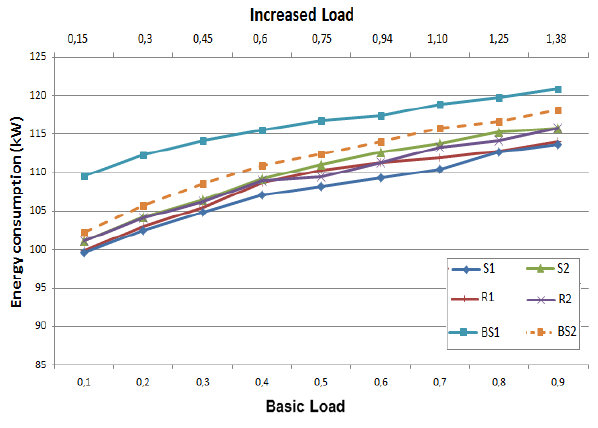
Figure 3: Energy consumption of the